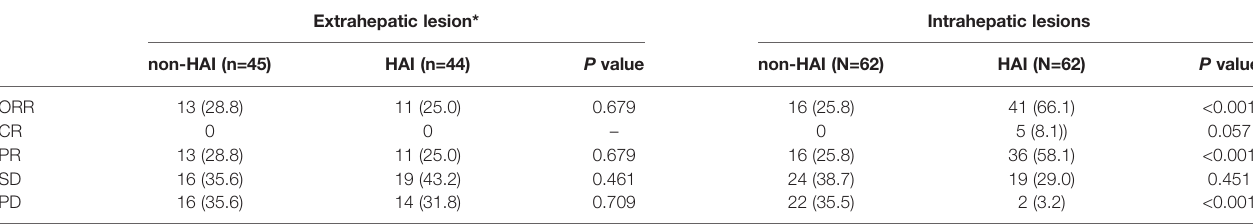
TABLE 2 | Objective response rate n